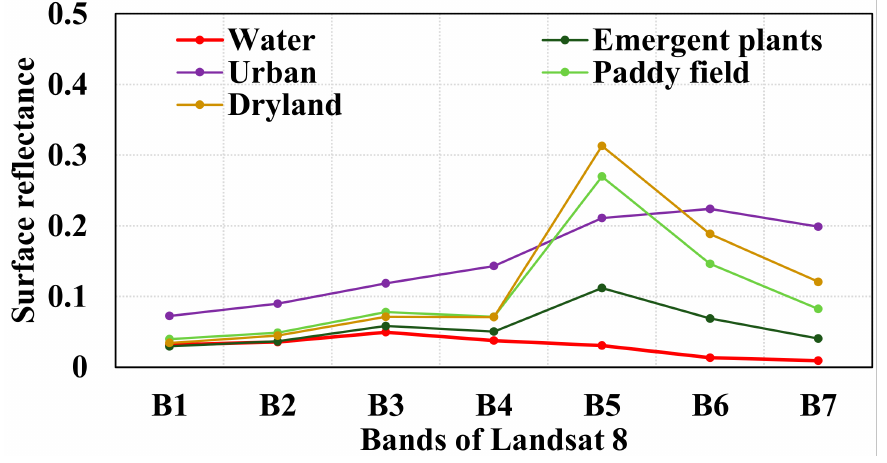
Figure 9. Spectral pattern of reflectance of the different land cover types in spring, summer, and autumn. The water surface area and corresponding estimated hydrological connectivity in the water level range of 8.0–8.2 m show significantly high fluctuations for spring, summer, and autumn in all of the years, which implies high water surface classification errors over this range. Figure 10 shows the relationship between lake level and total lake water surface area in 10-cm increments (including open water area and surface of water under emergent plants) derived from a field survey [72]. The water area variation is approximately 10 km 2 when water level is lower than 8.0 m. The total water area increases significantly in the water level range of 8.0–8.3 m, which indicates that the lake topography changes remarkably and that the Landsat 8 images and water index methods used here do not trace the changes in open water areas with sufficient accuracy over this water level range.